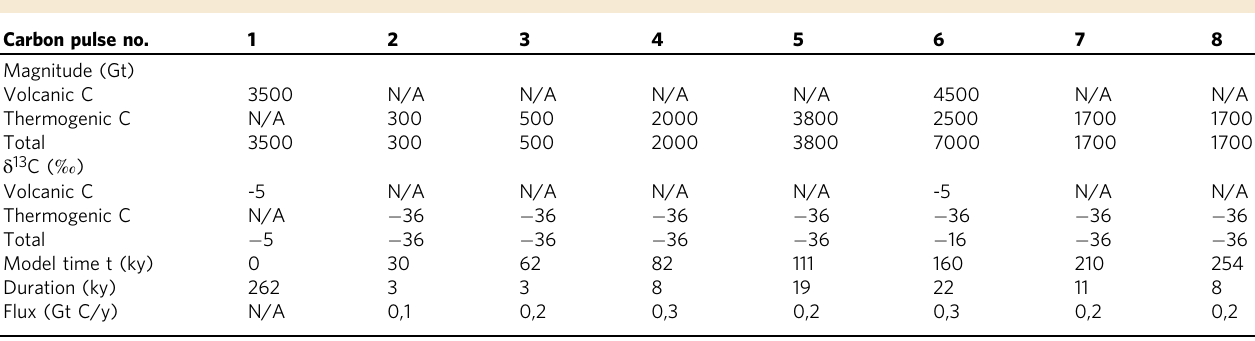
Table 1 Overview and input values for Karoo emission scenario. Carbon pulse